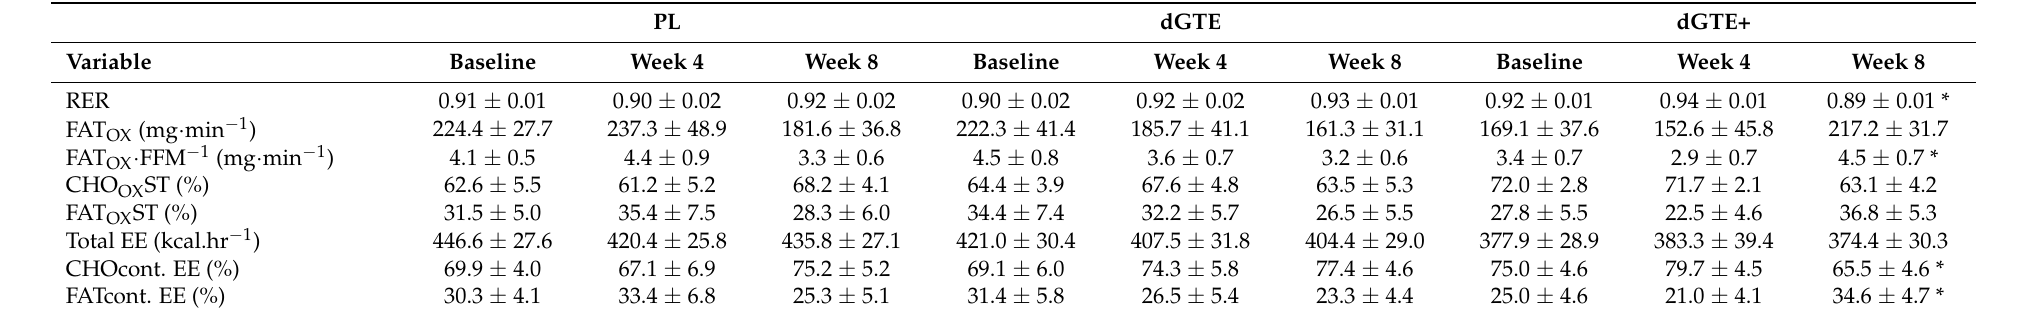
Table 5. Mean steady state exercise measures at baseline (week 0), week 4 and 8 between intervention